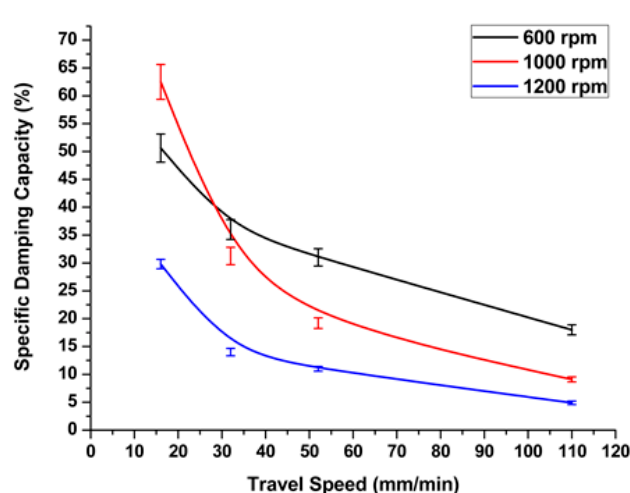
Figure 6. Effect of welding rate on damping capacity at different rotation speeds.